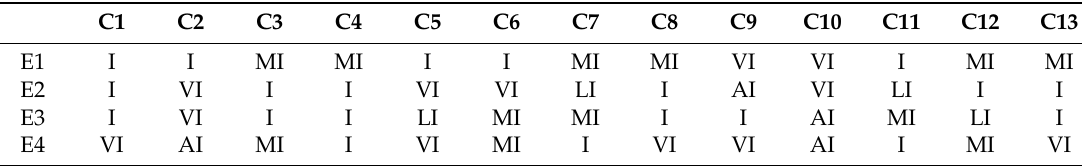
Table 4. Linguistic ratings for sub-criteria weights.